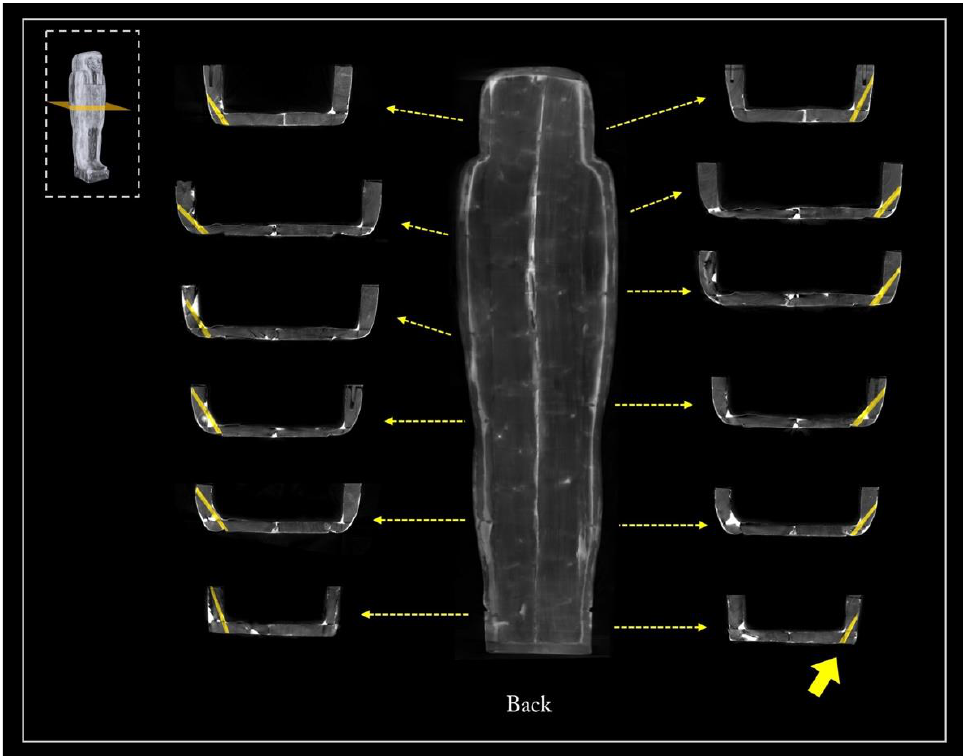
Figure 19. Axial sections showing the joint of the left and right side planks to the floor board by means of numerous dowels (in yellow). The arrow indicates the insertion direction of the dowels.